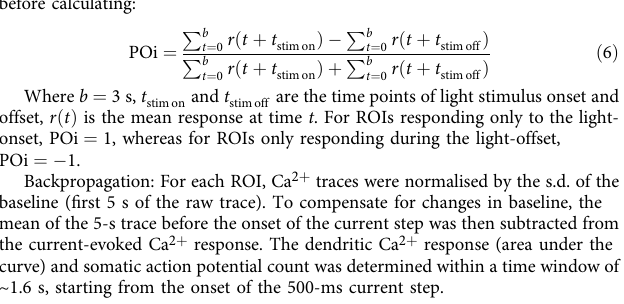
Table 3 Model parameters.